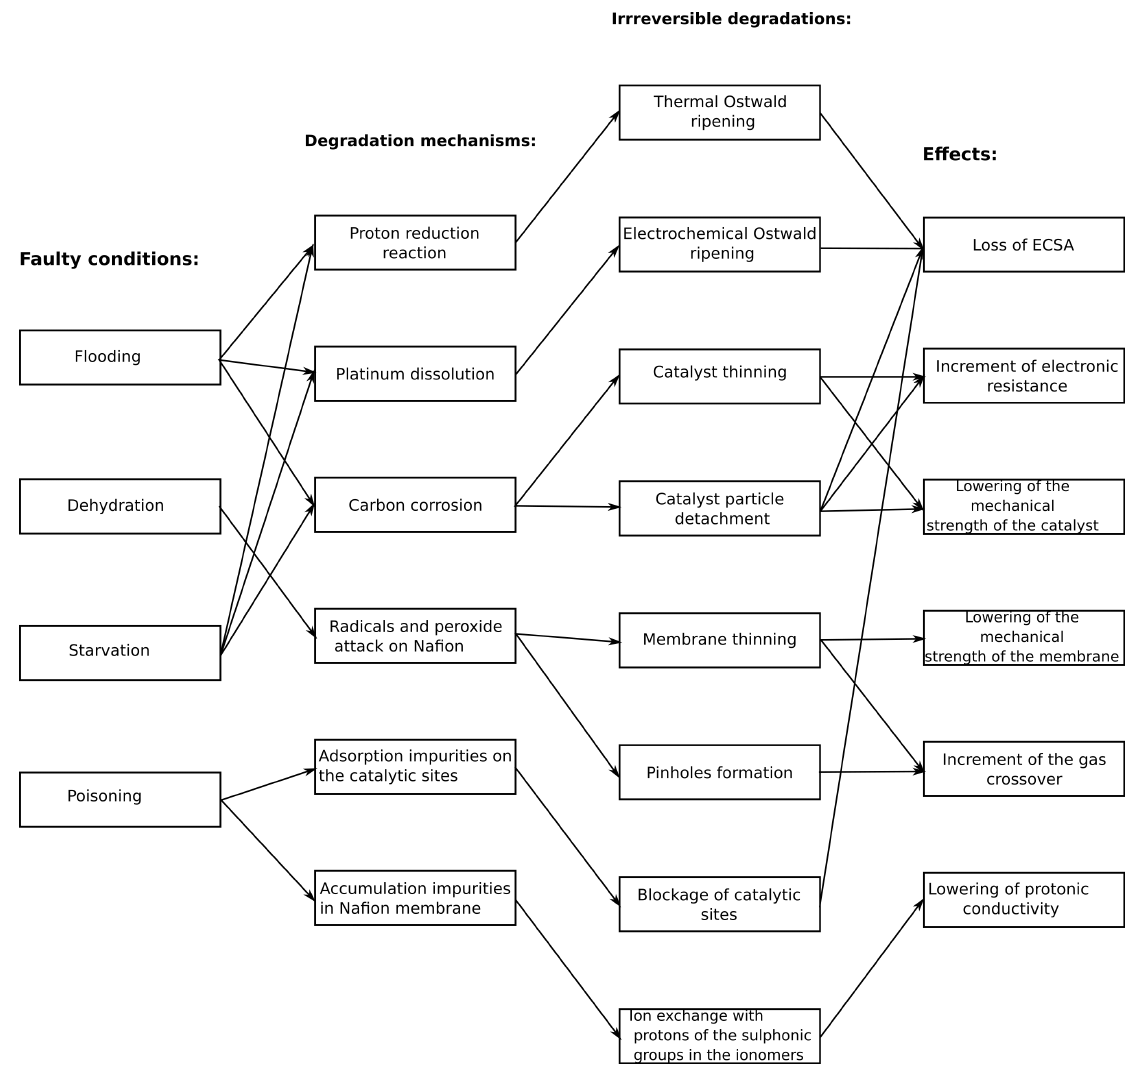
Figure 1. Schematic of the relations between faulty conditions, degradation mechanisms, irreversible degradation, and their